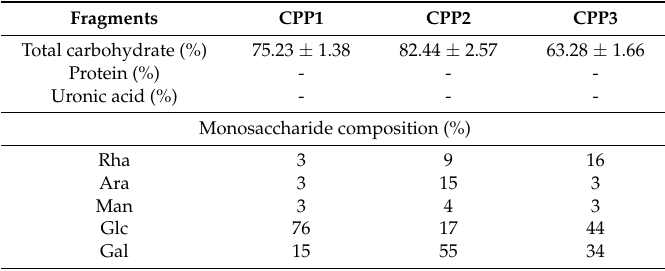
Table 1. Major chemical composition of the CPPs.